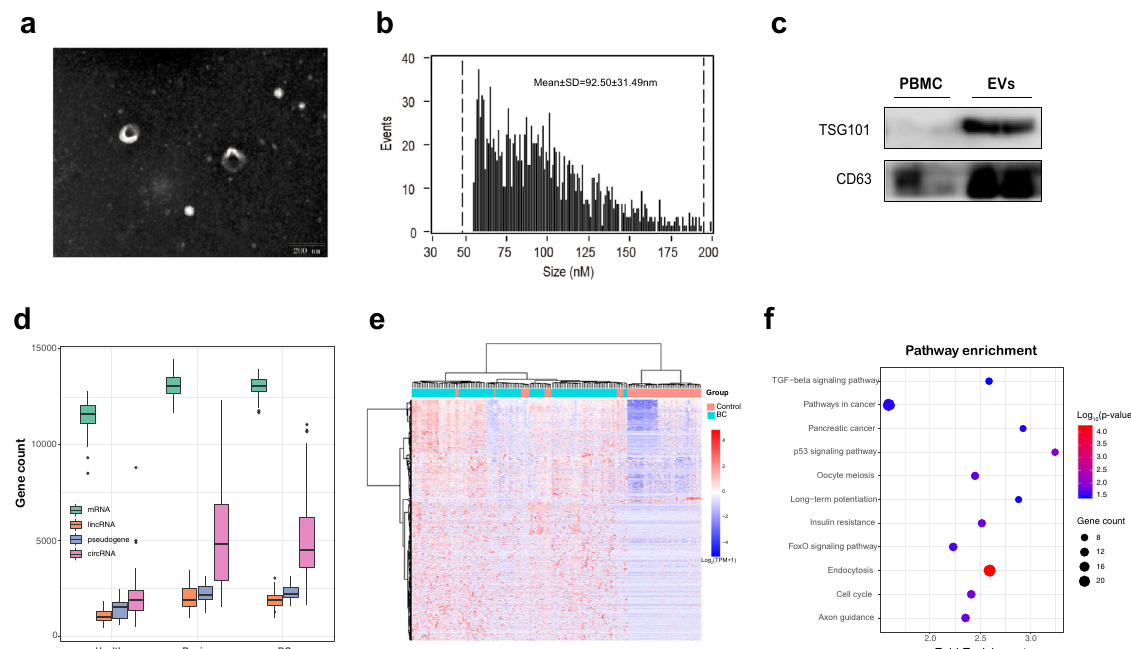
Fig. 1 ExLR pro fi les of the cohort. a , b EVs were detected by transmission electron microscopy ( a ) and fl ow cytometry ( b ). Scale bar, 200 nm. c Western blots of EV markers TSG101 and CD63 expression in peripheral blood mononuclear cells (PBMC) and isolated vesicles. d The distribution of exLRs per sample among BC, benign, and healthy patients. e Heatmap of unsupervised hierarchical clustering of the exLRs that were differentially expressed between BC patients and controls (healthy + benign). Each column represents an individual sample, and each row represents an exLR. The scale represents the expression values. f KEGG pathway enrichment analysis for the differentially expressed exLRs.